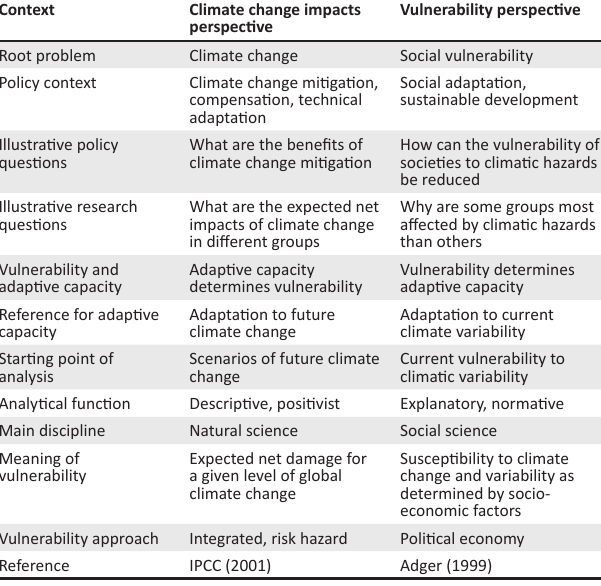
TABLE 1: Conceptualisation of climate change impact and